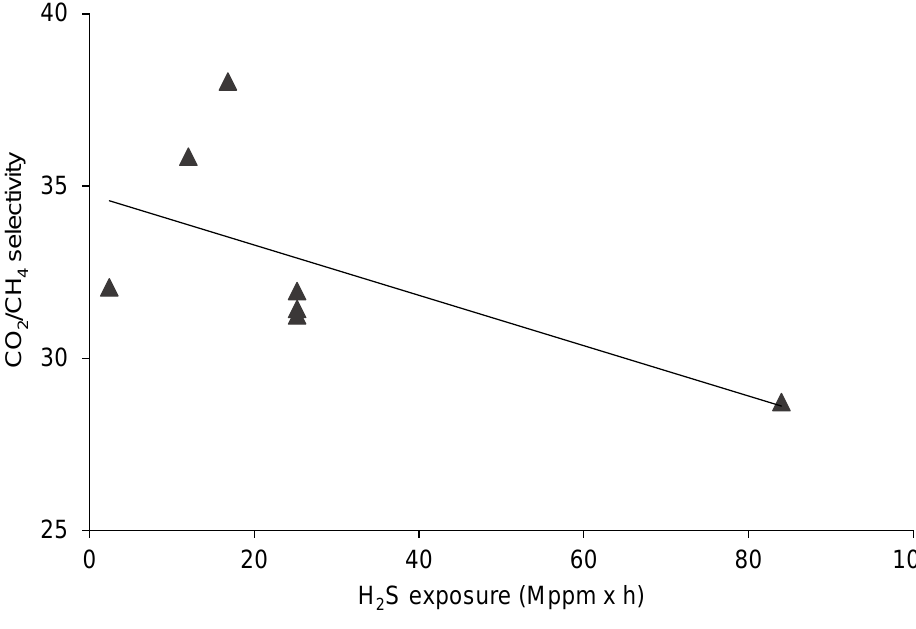
Figure 7. The effect of H 2 S exposure on CO 2 /CH 4 selectivity.